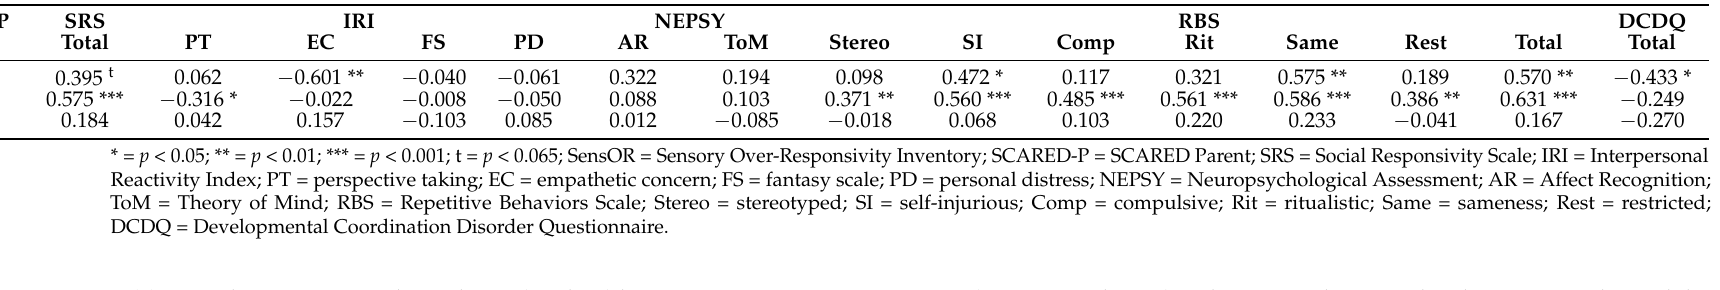
Table 3. Within-group partial correlation (r values) between sensory over-responsivity (SensOR total score) and anxiety subscores, alexithymia, empathy, and the CBCL, while controlling for age, sex, and IQ by